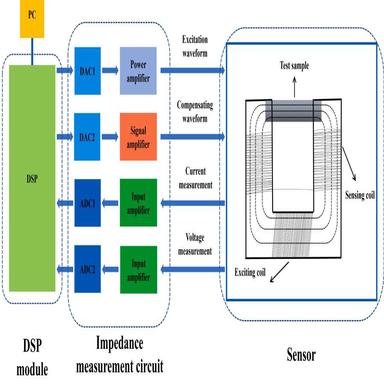
Multi-frequency electromagnetic detection system.